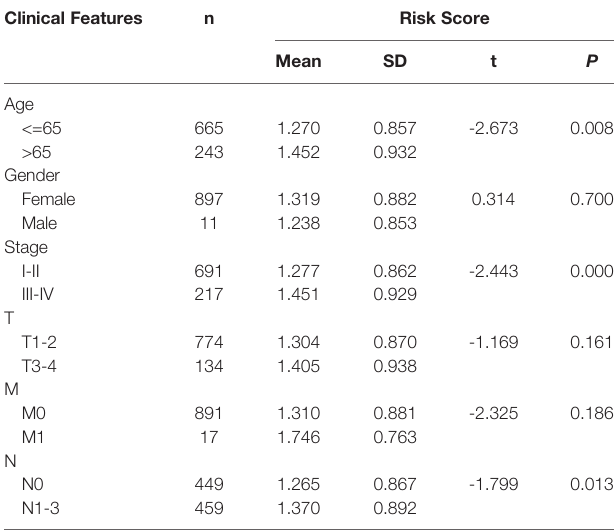
TABLE 5 | Clinical impact of risk score signature for the TCGA